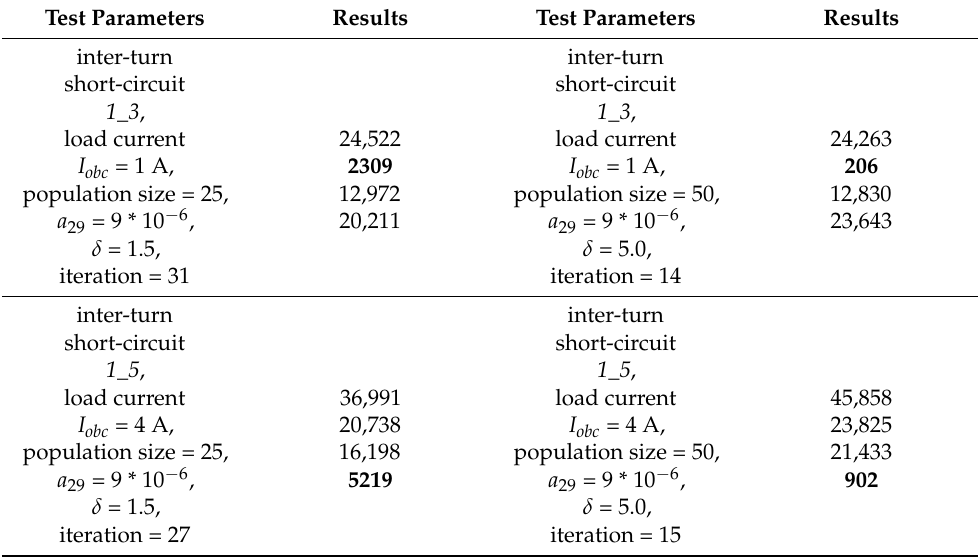
Table 3. Example results of H 2 matrix tests for the signal proportional to axial flux φ 1 .